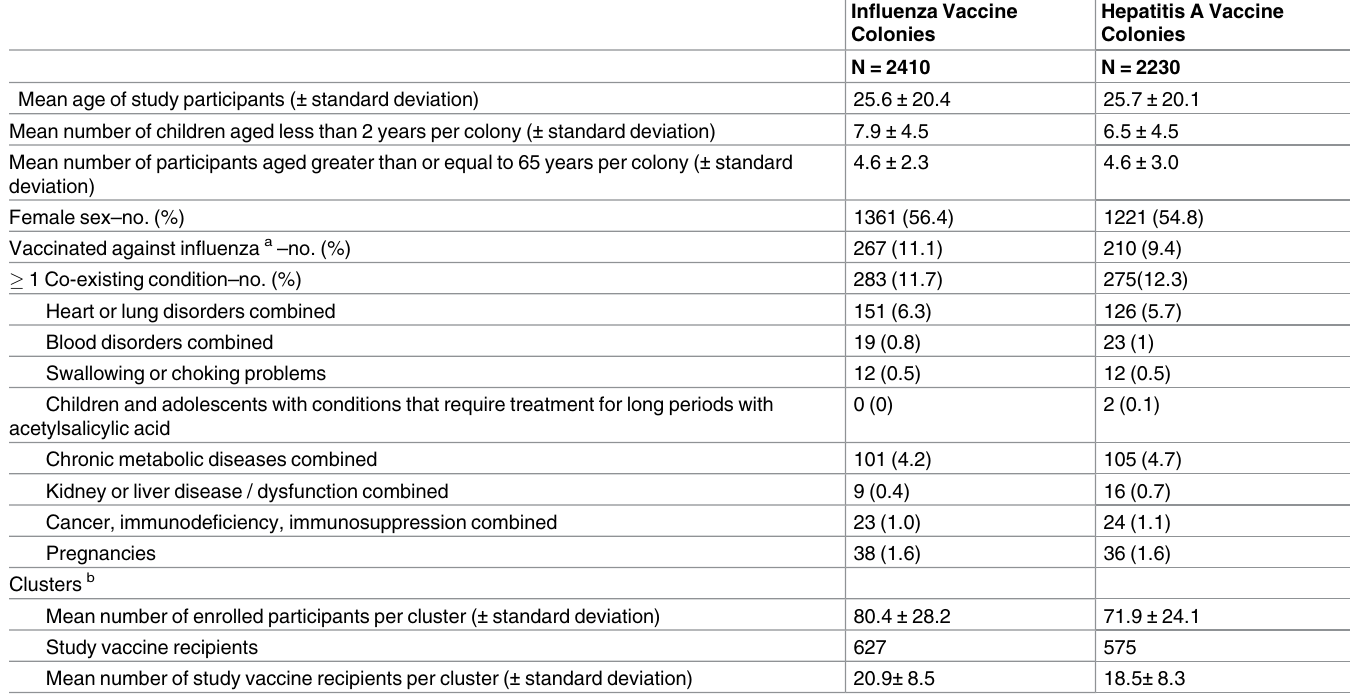
Table 1. Baseline Characteristics of All Study Participants in 65 Colonies (32 in Influenza Vaccinated Group and 33 in Hepatitis A Vaccinated group) at First Entry to